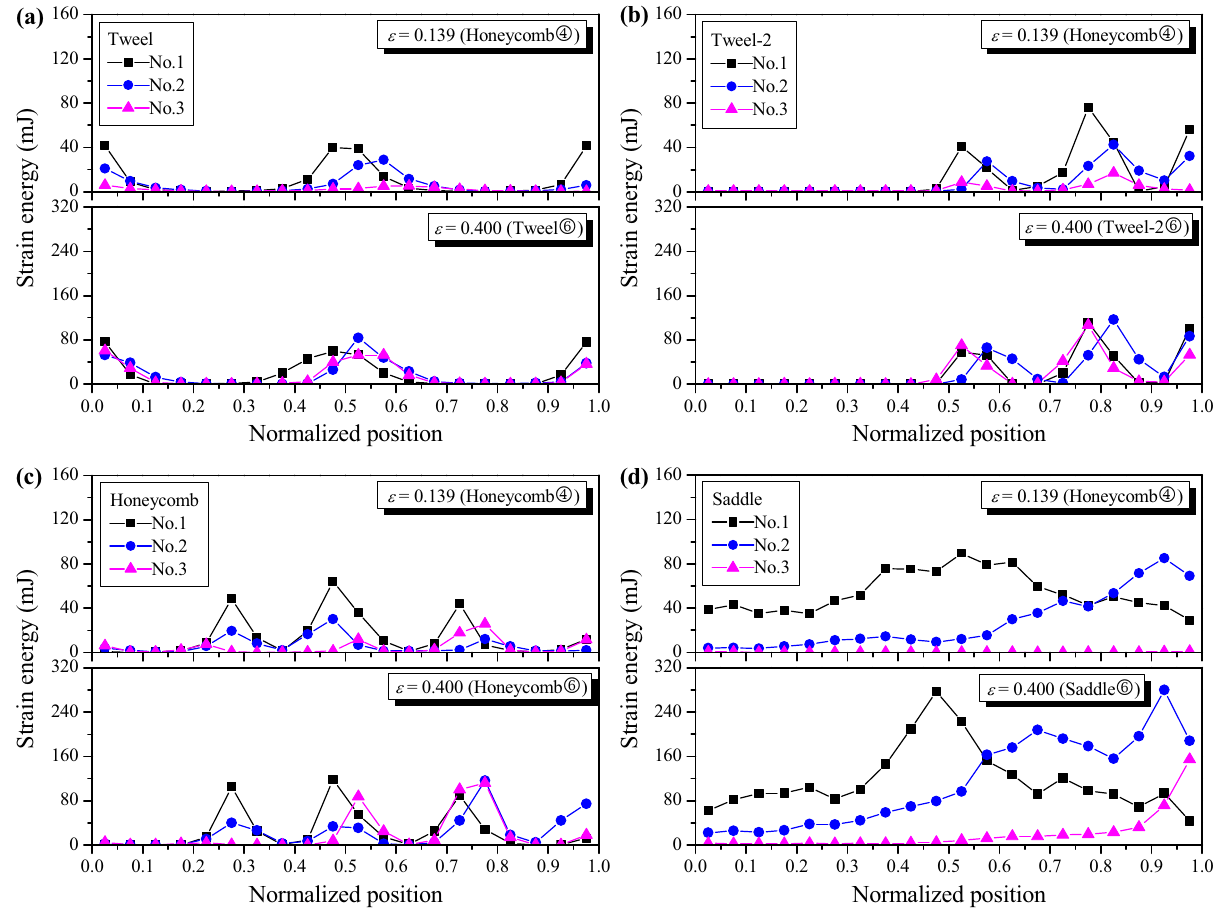
Figure 11: Radial distribution curves of strain energy of ( a ) Tweel; ( b ) Tweel - 2; ( c ) honeycomb; and ( d ) saddle tire